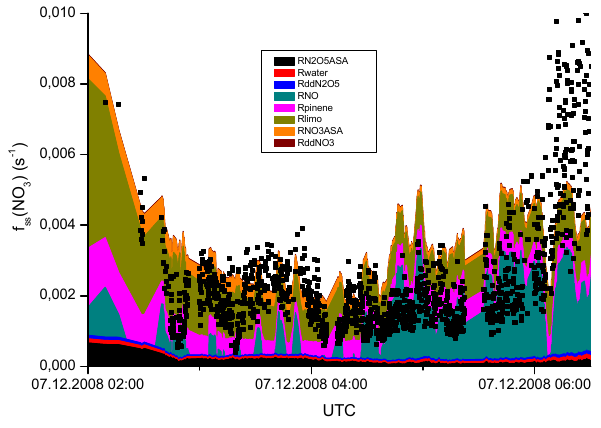
Fig. 6. Apportioned NO 3 loss rates during the night 6th–7th De- cember. The various contributions are: RN 2 O 5 ASA=uptake of N 2 O 5 to aerosol, Rwater=homogeneous hydrolysis of N 2 O 5 with water vapour, RddN 2 O 5 =dry deposition of N 2 O 5 , RNO=reaction of NO 3 with NO, Rpinene=reaction of NO 3 with α -pinene, Rlimo=reaction of NO 3 with limonene, RNO 3 ASA=reaction of NO 3 on aerosol, RddNO 3 =dry deposition of NO 3 . The solid, black datapoints are measurements of the loss frequency of NO 3